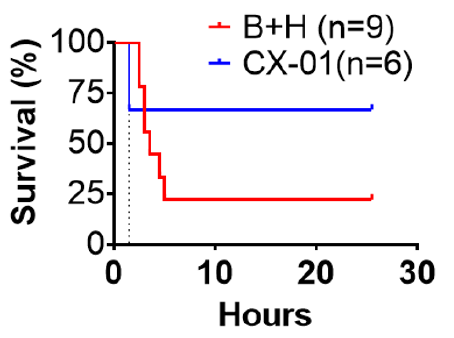
Figure 7. Effect of CX-01 treatment on injury survival in the rat model. Animal survival was monitored up to 24 h after TH. Survival distribution of these two groups was assessed by the log-rank Mantel-Cox test ( p = 0.24).